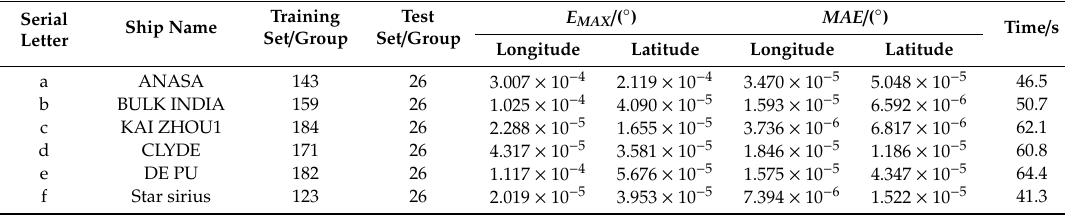
Figure 13. Prediction results of f-trajectory using the ACDE-SVR model. ( a ) Comparison of predicted and actual values of f-trajectory; ( b ) Longitude and latitude absolute error values of f-trajectory. Table 7. Comparison of prediction results for different ship trajectory sequences.